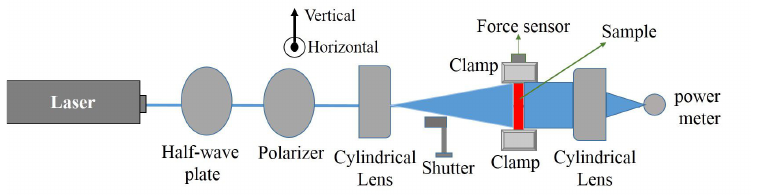
Figure 6. The optical path in the photomechanical experiment that is used to measure stress as a function of time, strain, pump intensity and temperature. Oven is not